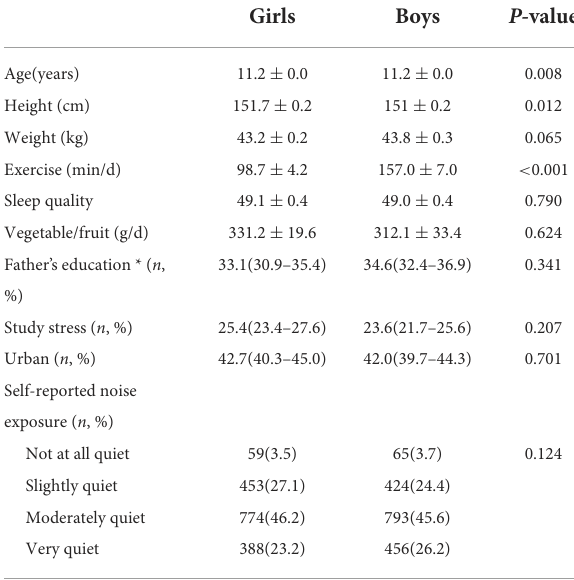
TABLE 1 Characteristics of participants by